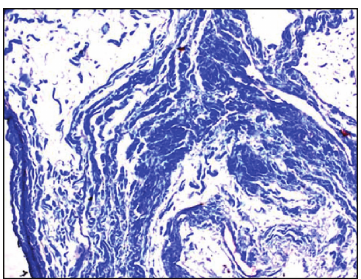
Figure 2: Microphotograph of native bovine gallbladder showing dense compact arrangement of collagen fibers (Masson’s trichrome stain, 200x).